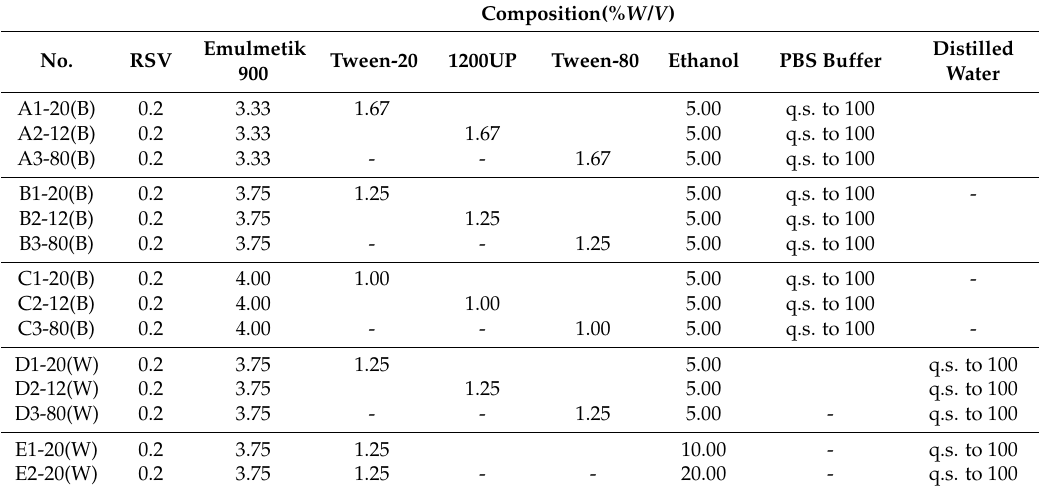
Table 3. Changeable experimental parameters to affect